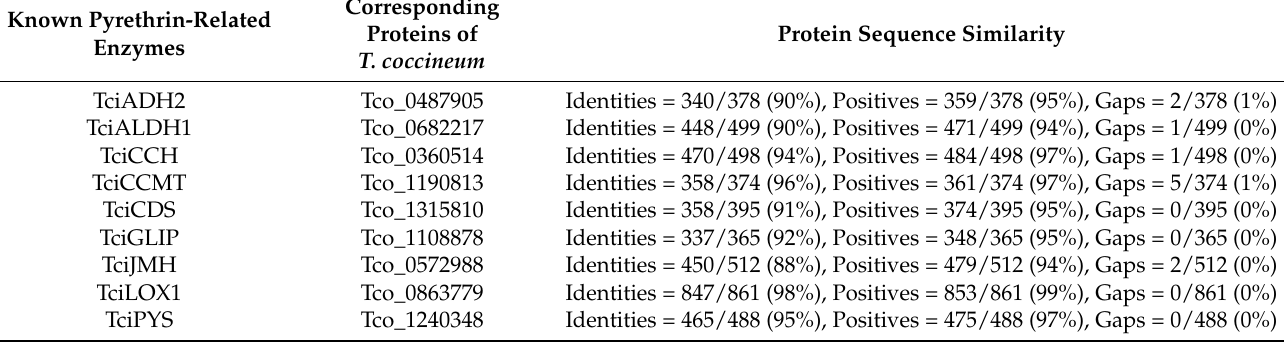
Table 5. T. coccineum genome-encoded proteins corresponding to known pyrethrin biosynthesis- related